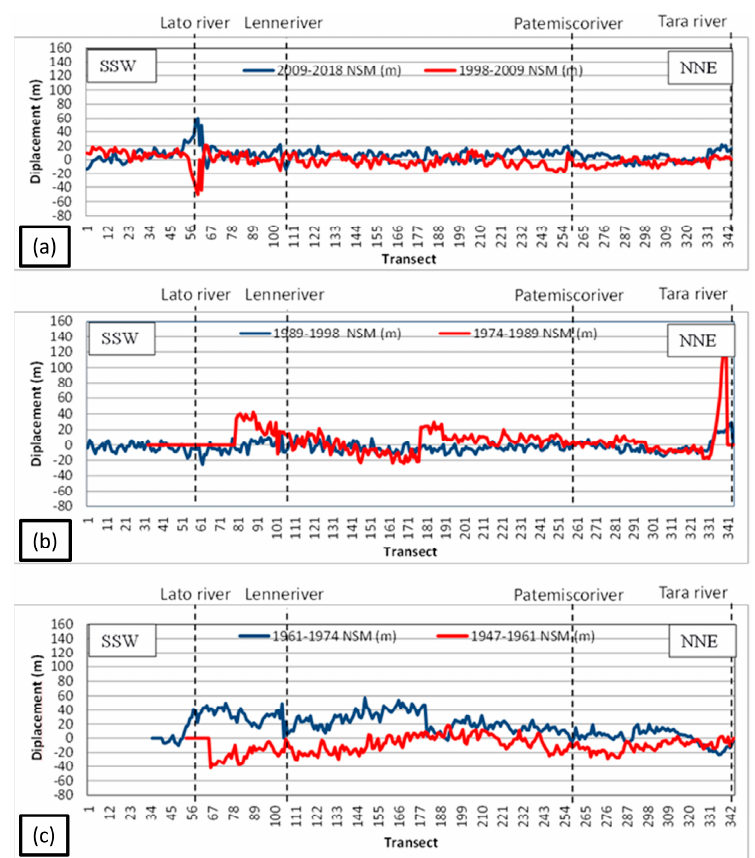
Figure 9. Net Shoreline Movement (NSM) for the study area: ( a ) NSM during the 2009–2018 and